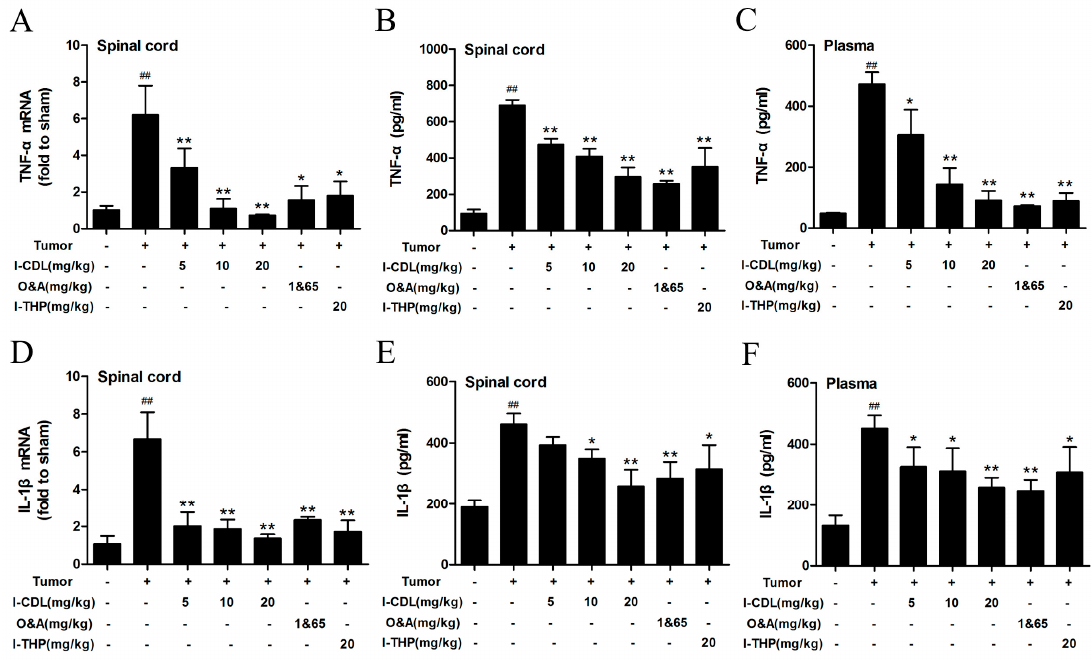
Figure 3. l -CDL attenuated tumor compression-induced TNF- α and IL-1 β expression in serum and spinal cord. ( A ) The expression of TNF- α mRNA in the spinal cord; ( B ) The level of TNF- α protein in the spinal cord; ( C ) The level of TNF- α protein in serum; ( D ) The expression of IL-1 β mRNA in the spinal cord; ( E ) The level of IL-1 β protein in the spinal cord; ( F ) The level of IL-1 β protein in serum. ## p < 0.01 vs. sham group. * p < 0.05, ** p < 0.01 vs. tumor group. (mean ± S.D., n = 3).